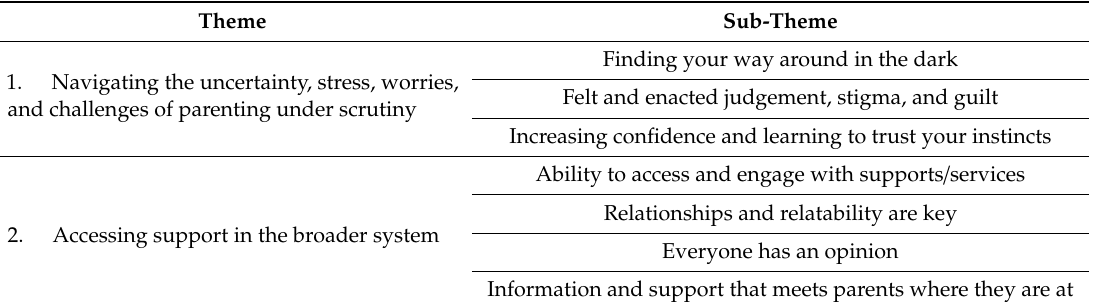
Table 2. Overview of themes and